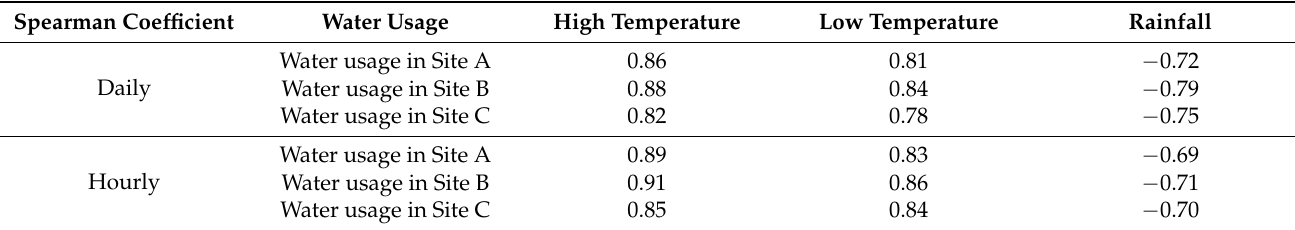
Table 4. The Spearman coefficients between water usage, temperature, and rainfall 1 . Spearman